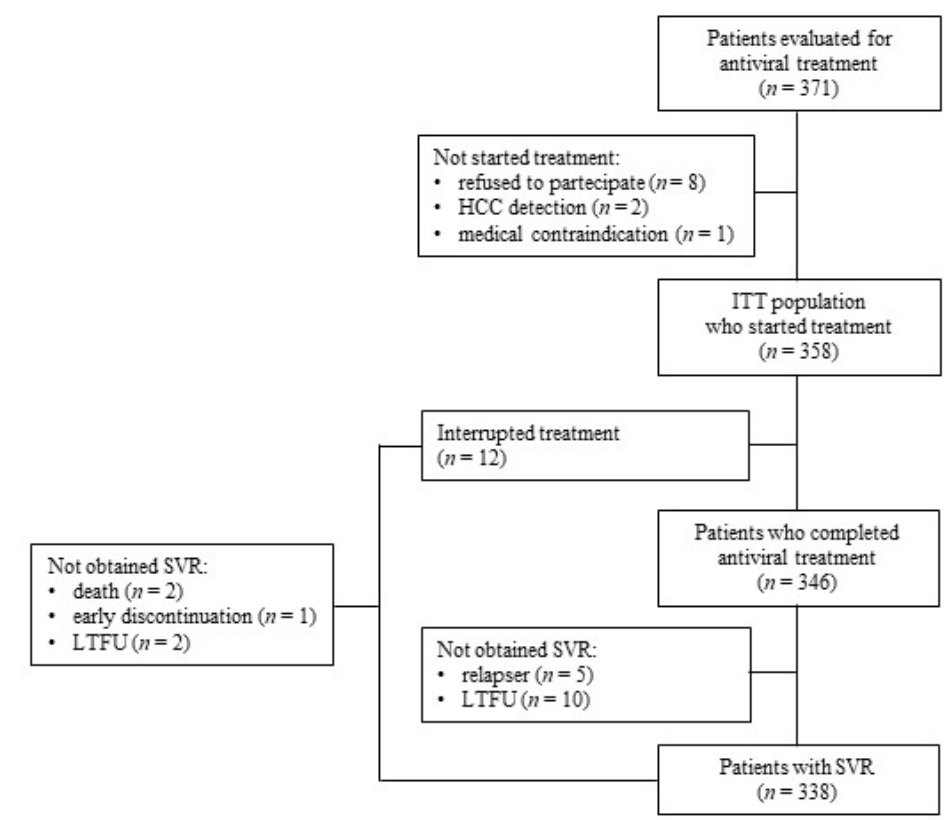
Figure 2. Derivation of the analysis population. ITT, intention-to-treat; LTFU, loss to follow-up; SVR, sustained virologic response; mITT, modified intention-to-treat.